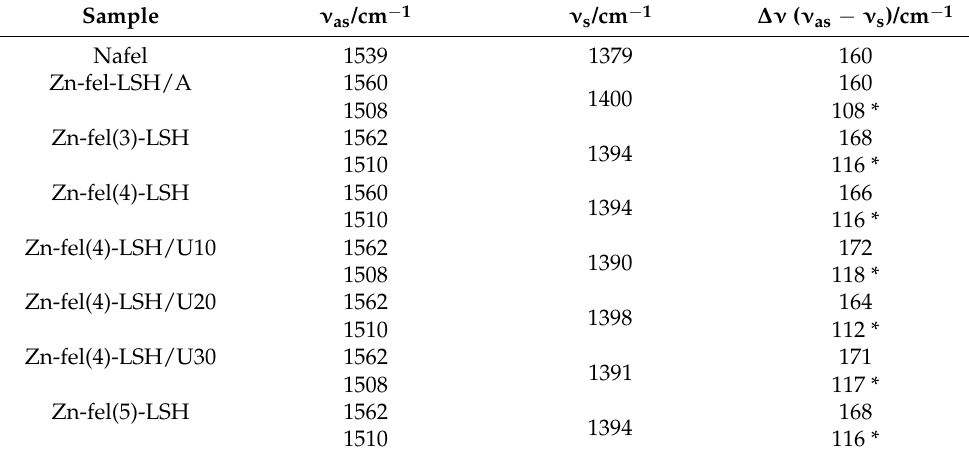
Table 2. Frequencies of the carboxylate asymmetric and symmetric stretching modes and frequency difference values ( ∆ ν = ν as − ν s ) between carboxylate stretching modes of the sodium ferulate salt (Nafel—NaC 10 H 9 O 4 ) and LSH-ferulate materials.